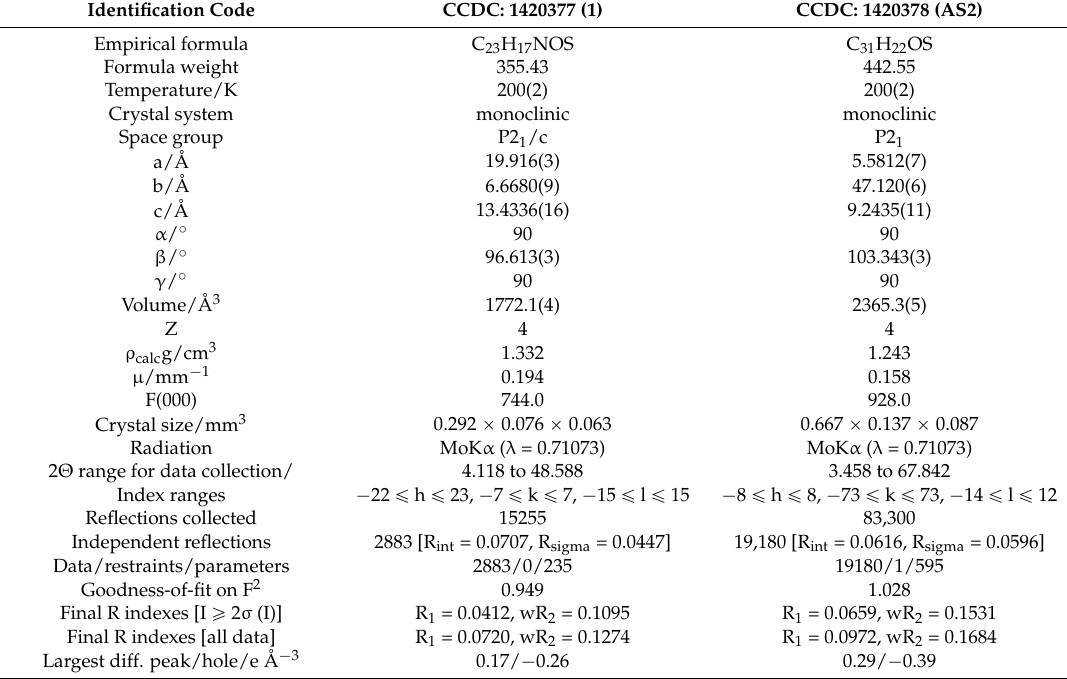
Table 1. Details of crystal data and structure refinement parameters of 1 and AS2 .